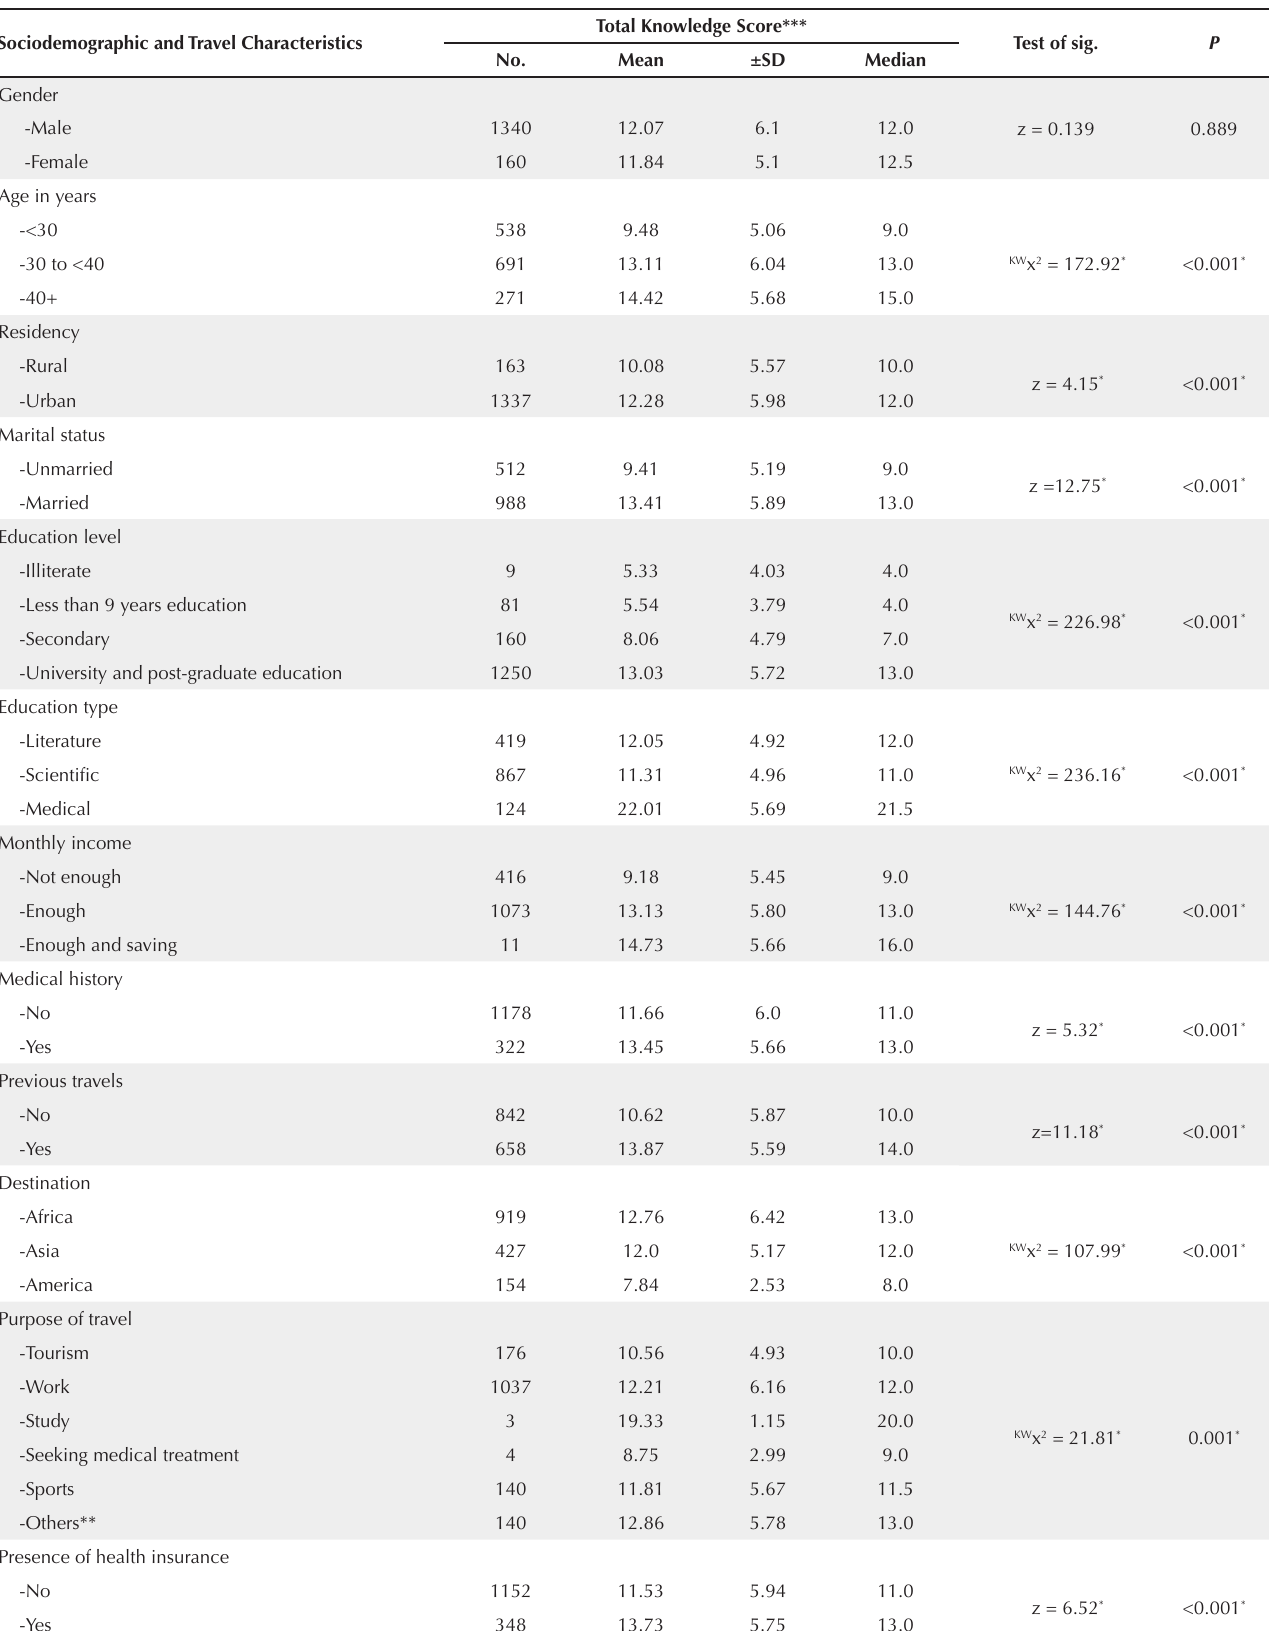
KW: Kruskal Wallis test for comparing between the different studied group; z: z value for Mann Whitney test. *Statistically significant; ** Others = Parents or husband accompanying; visiting relatives; attending conference; making a movie; Quran memorization competition; relief committee; traditional arts competition; ***Knowledge total score range